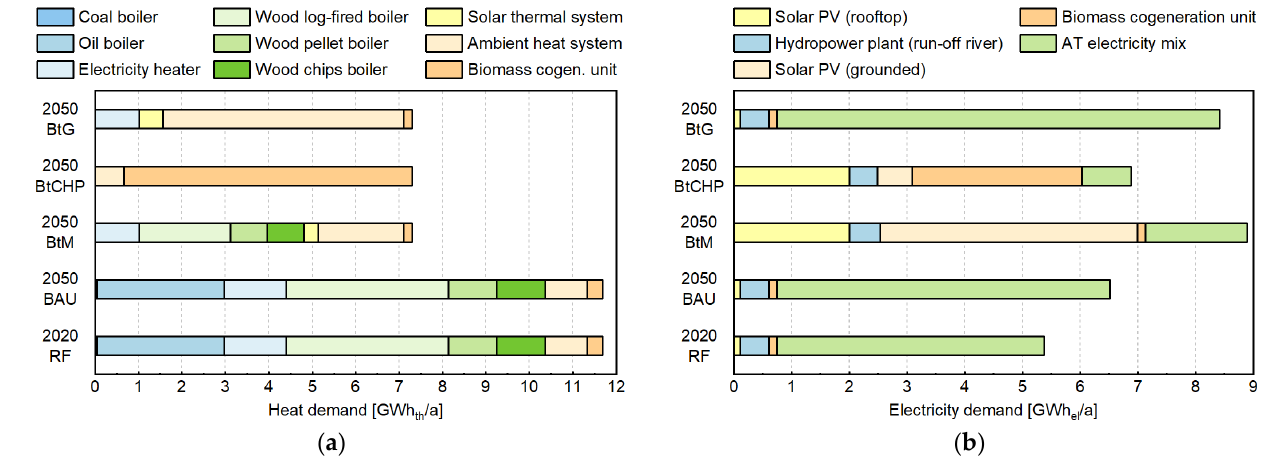
Figure 7. Comparison of final heat ( a ) and electricity ( b ) demands of the reference case (2020) with assumed scenarios (2050).